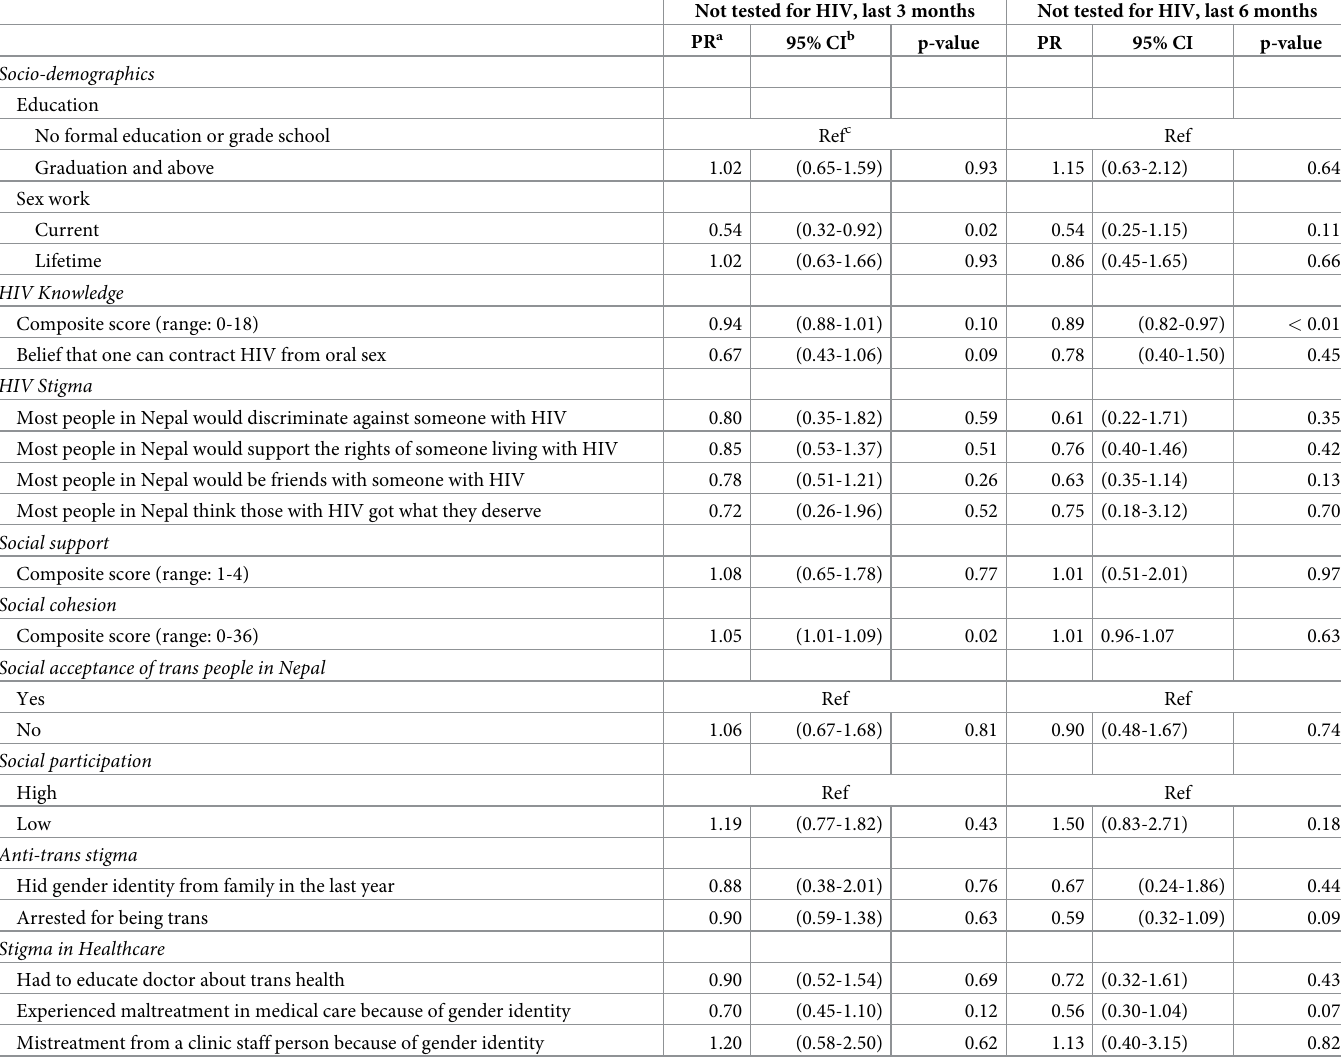
Table 4. Bivariable associations between negative indications of HIV testing engagement and socio-demographics, HIV knowledge, HIV stigma, social support, social cohesion, social acceptance, social participation, anti-trans stigma, and healthcare stigma among HIV-negative trans women, Tesoro Lingi, and people with other genders in Nepal (n = 173),